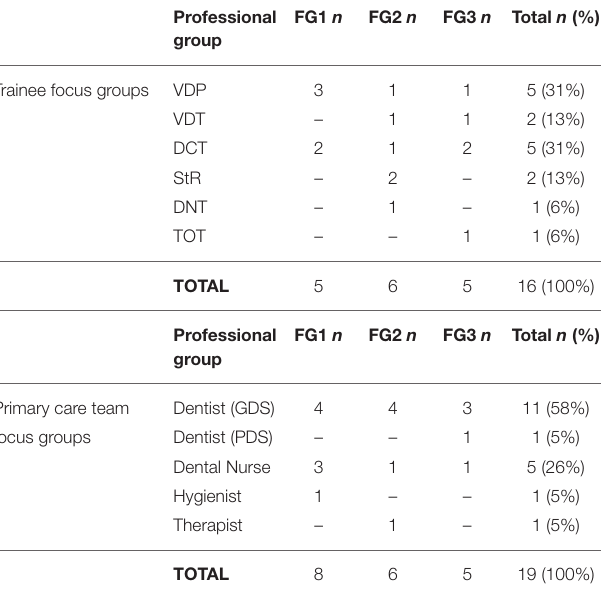
TABLE 1 | Focus group participants by professional